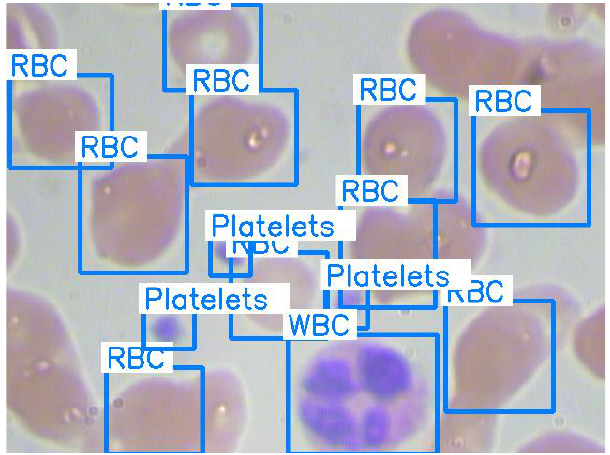
Figure 5. Original image with ground truth bounding boxes and labels.